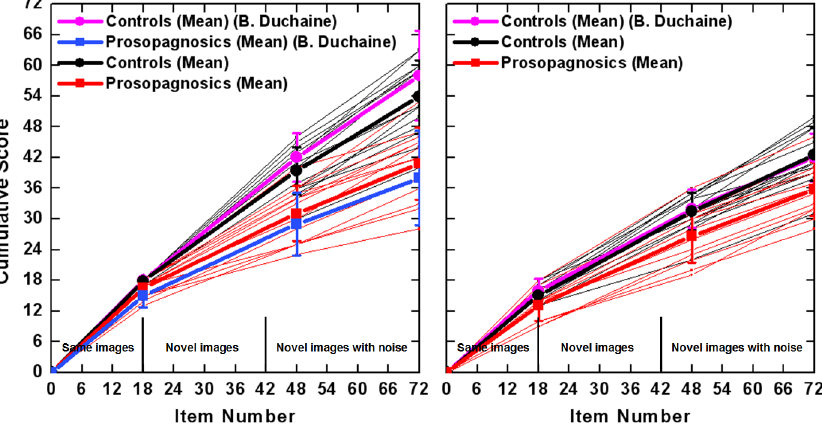
Fig 3. Comparison of the results of the Cambridge Memory Test for Faces (CMTF) in this study to the original results to standardize the CMTF [12]. Summary scores from Appendix C from [12] were used with permission by Brad Duchaine. The present Figure was prepared in the style of Figs 4 and 5 from [12]. For the so called cumulative score the number of faces that were correctly recognized in the three sections of the CMTF were added up from the first to the third part. In the first part (called same images) the maximal number of recognized faces is 18, for the second part 30 (i.e. the cumulative score of part 1 and 2 is 48) and for the third part 24 (for more details see Duchaine and Nakayama 2006). Good to perfect correspondence between the present data and those from [12] can be seen for upright (left panel) and inverted faces (right panel). Note, that in the original study people with cPA did not perform the inverted version of the